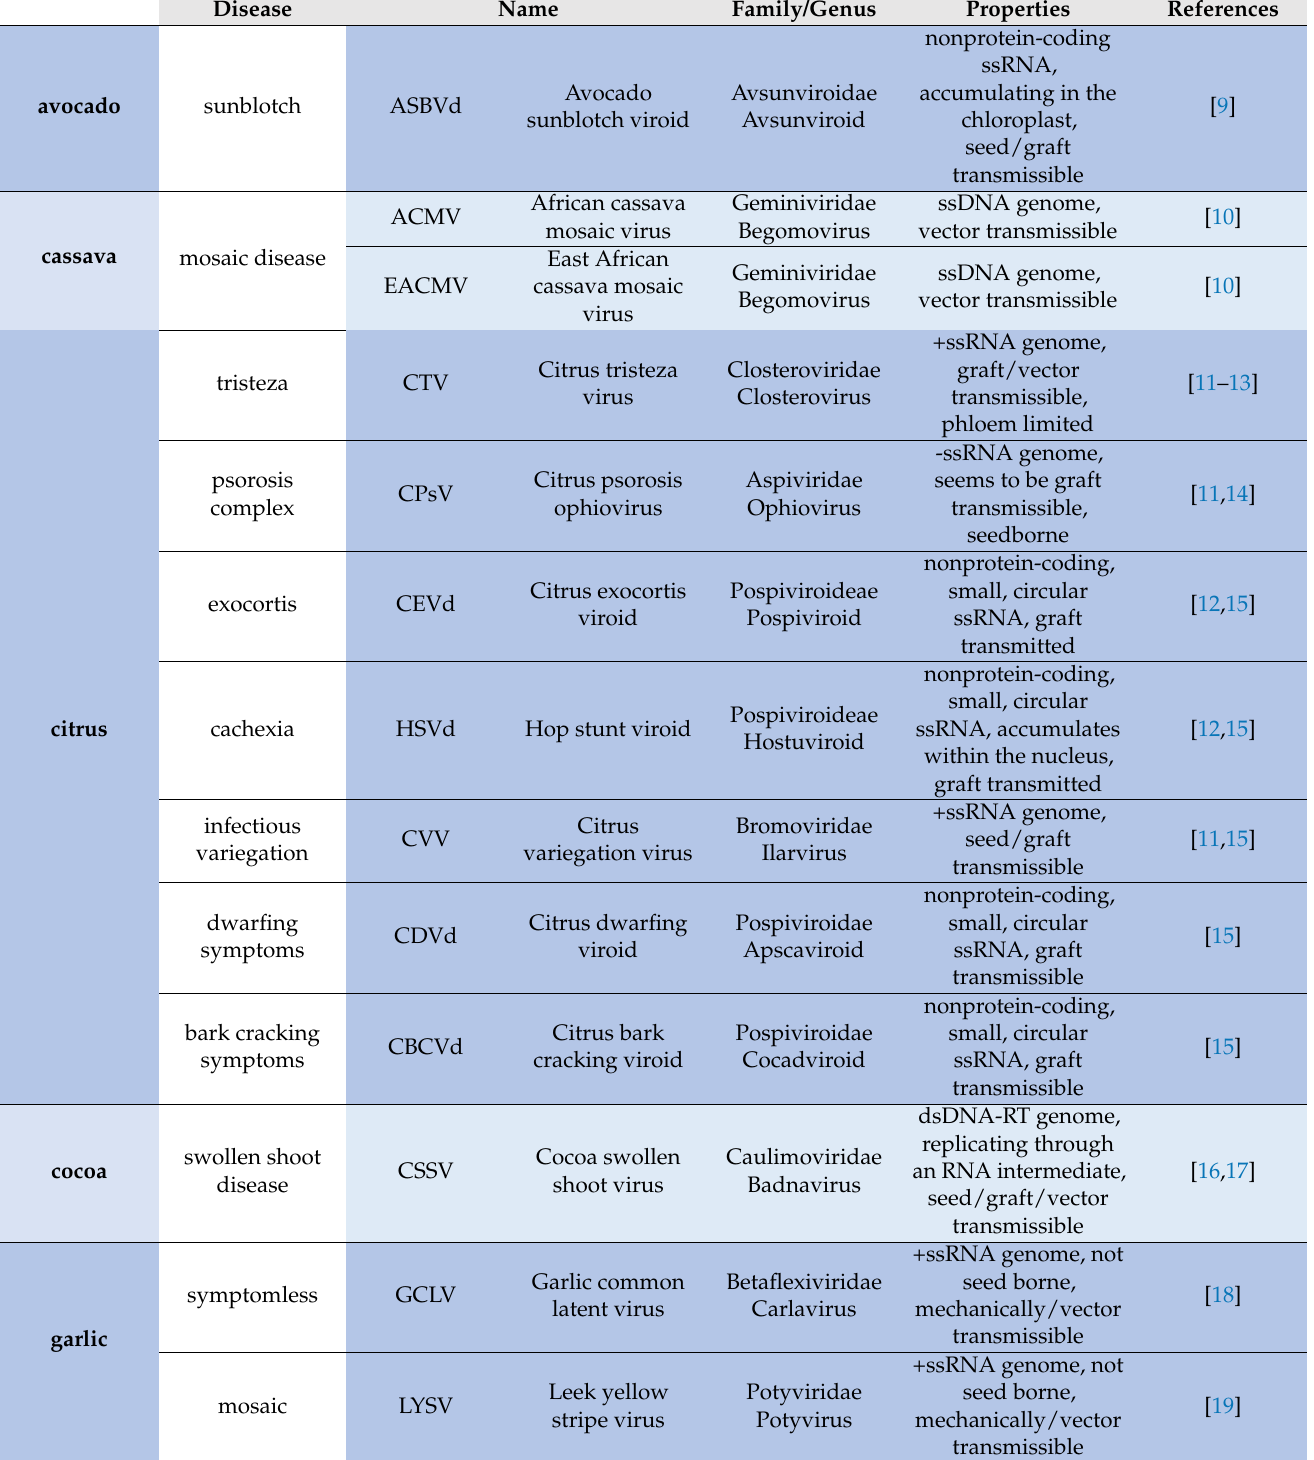
Table 1. Diseases in different plant species caused by viruses and viroids, which were tested in SE based elimination